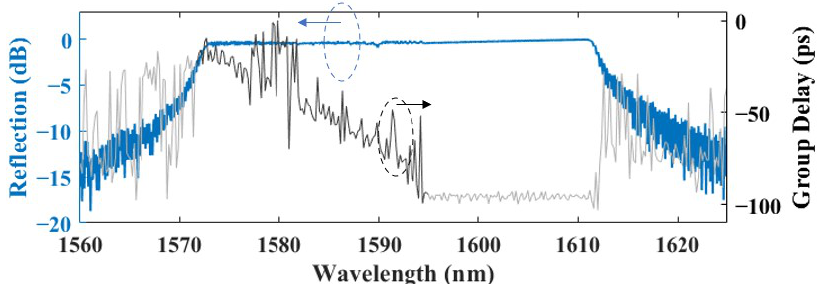
Figure 3. Simulated reflection spectrum and group delay of the CBG.